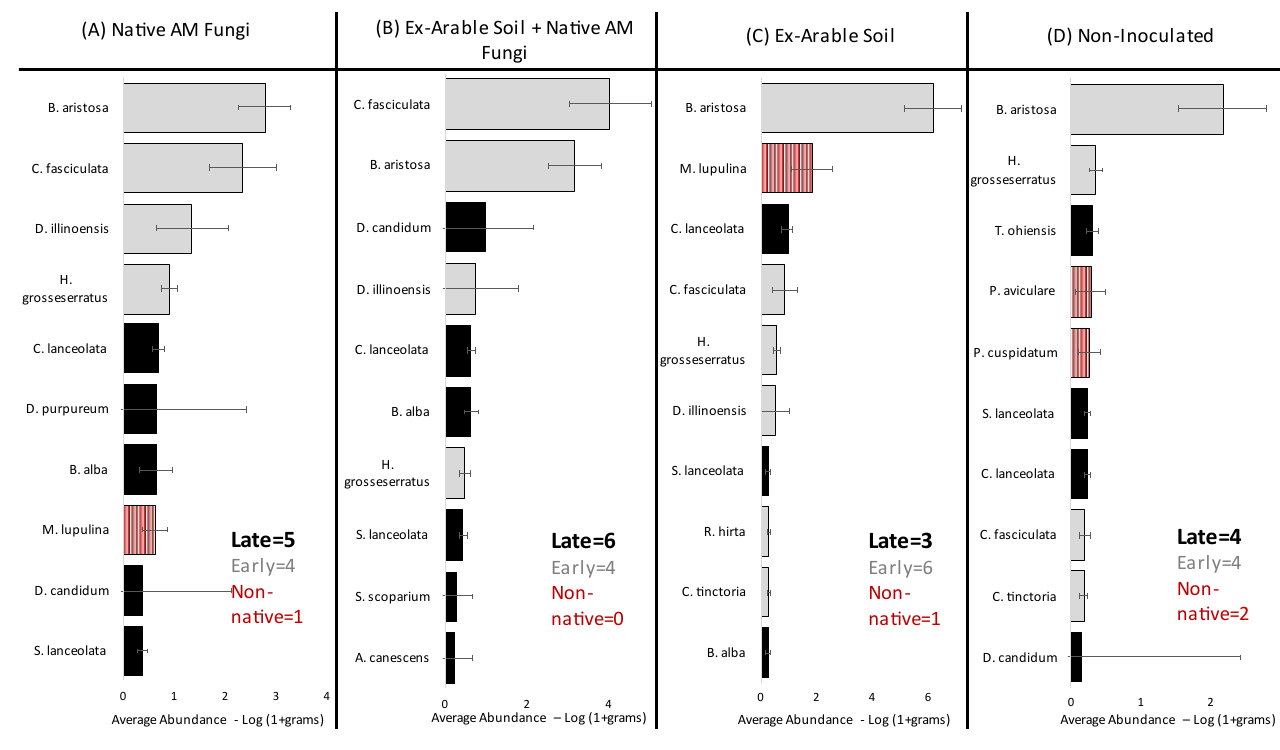
Figure 2. Rank abundance for pots inoculated with ( A ) native AM fungi, ( B ) native AM fungi + ex-arable soil, ( C ) ex-arable soil, or ( D ) non-inoculated control. Bars represent average species abundance (g), and error bars are standard error. Bar color is determined by plant coefficient of conservatism (CC) score, where gray bars represent early successional plants (CC = 1–4), black bars represent late successional plants (CC = 5–10), and red striped bars represent non-native (CC = 0) and non-seeded species. Table 2. The main effect of inoculation treatment (bold) and contrasts (italics) results from the PROC GLM model in SAS on ( A ) total diversity, abundance, and nativeness and ( B ) for seedling abundance within successional stages and functional